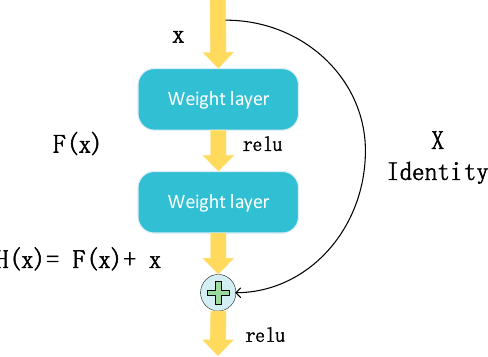
Figure 5. Residual unit structure diagram. ReLU, rectified linear unit.